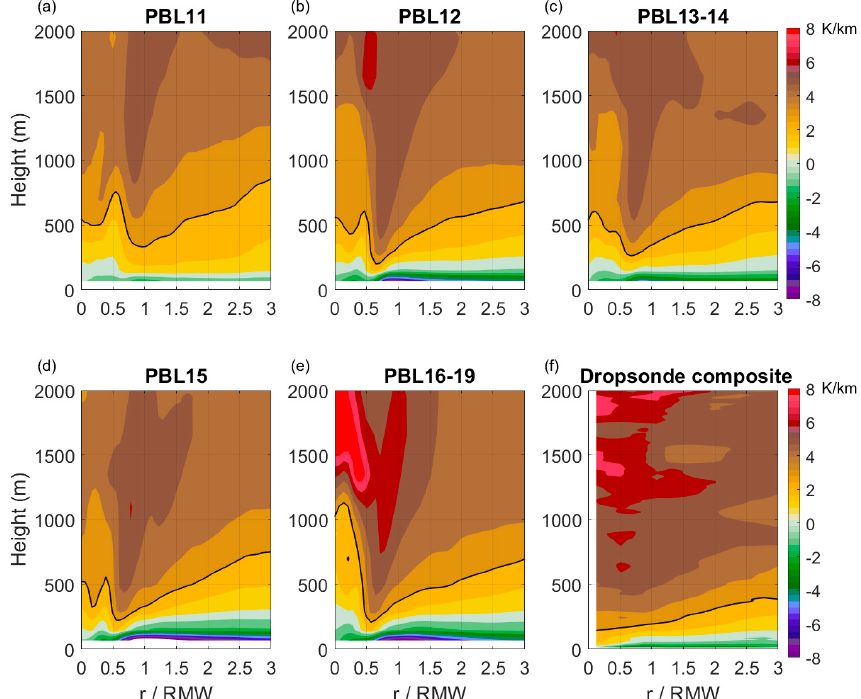
Figure 8. Normalized radius-height plot of the azimuthally averaged vertical gradient of the virtual potential temperature (d θ v / dz) over t = 84–108 h in the idealized HWRF simulations with ( a ) PBL11, ( b ) PBL12, ( c ) PBL13–14, ( d ) PBL15, and ( e ) PBL16–19 schemes. The dropsonde composite of d θ v / dz is shown in ( f ). The black line is the 3K / km contour, which represents the thermodynamic PBL height. RMW is the radius of the maximum wind speed.